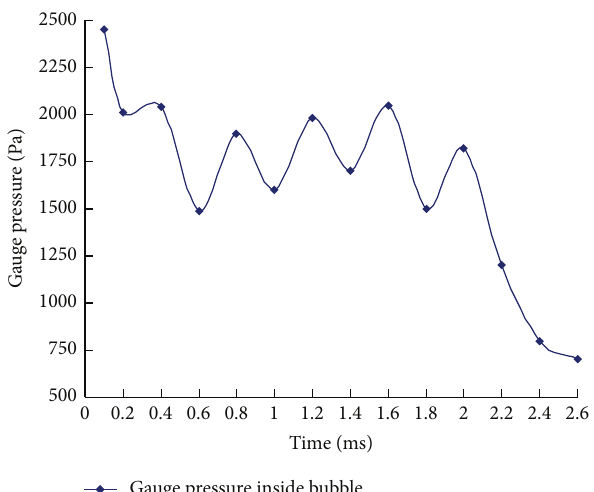
Figure 8: The gauge pressure inside bubble varying with bubble growth and detachment time on case 1